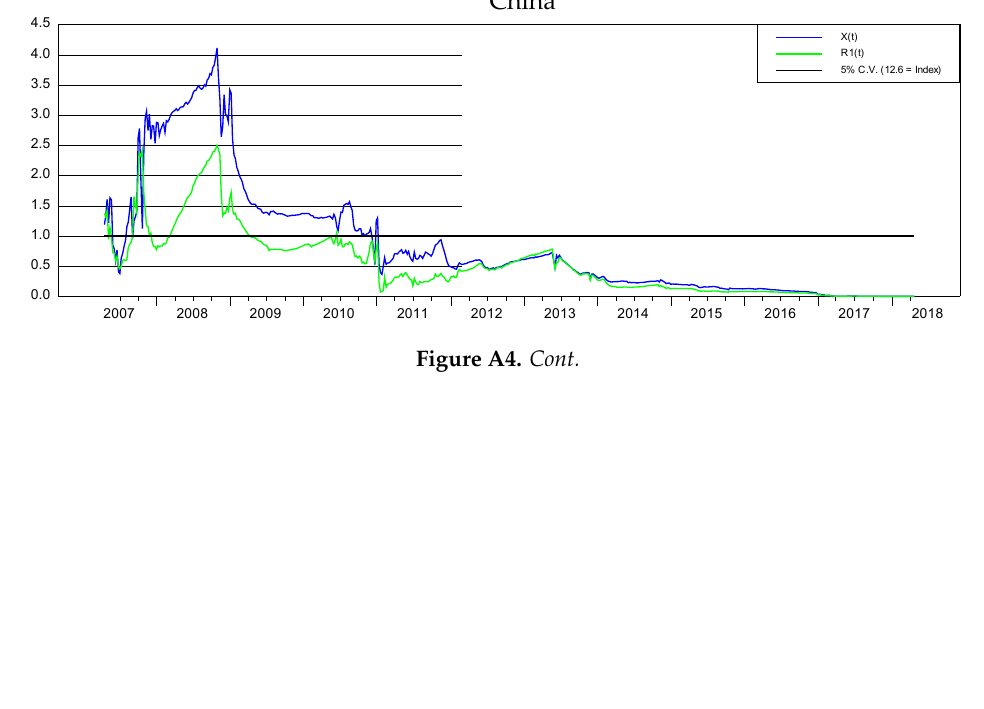
Figure A3. Recursively estimated Parameter Constancy “Known- beta Test”. Note: "X-representation" denotes that all parameters of the cointegrated VAR system are re-estimated during the recursions, while under the "R-representation", only the long-run parameters are re-estimated. The graphs are scaled by the 5% critical value and therefore the null of parameter stability is rejected if the test value exceeds the value of one.